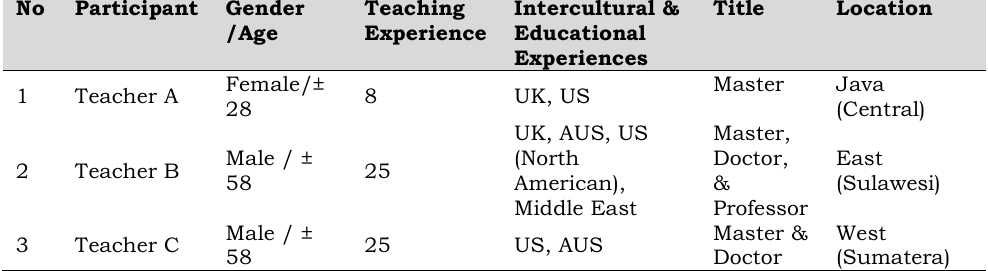
Tabel 1. Teacher participants’